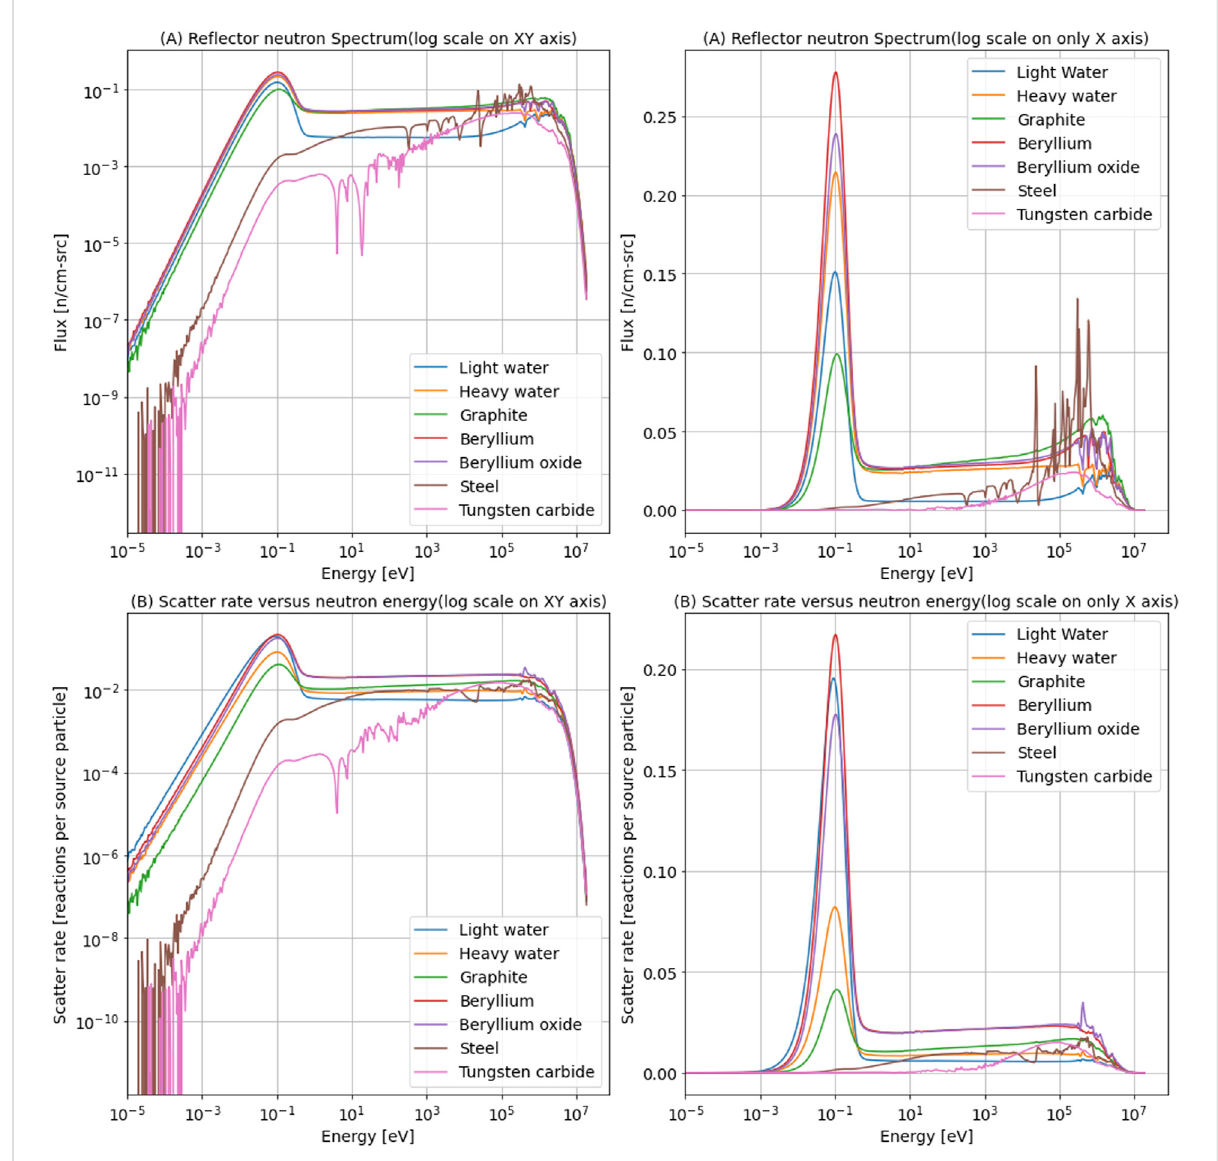
FIGURE 6 The incident neutron energy spectra and scattering reaction energy distributions within re fl ector